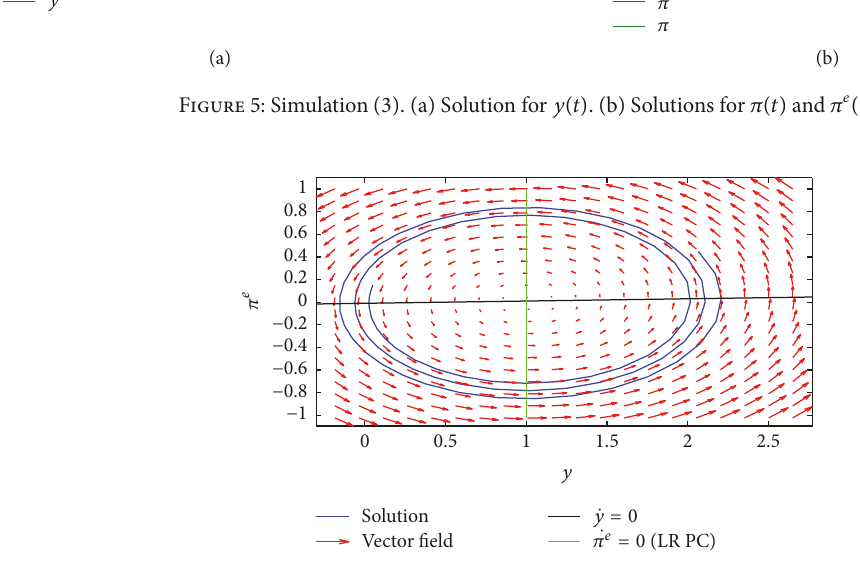
Figure 6: Simulation (3) . Phase diagram illustrates an unstable